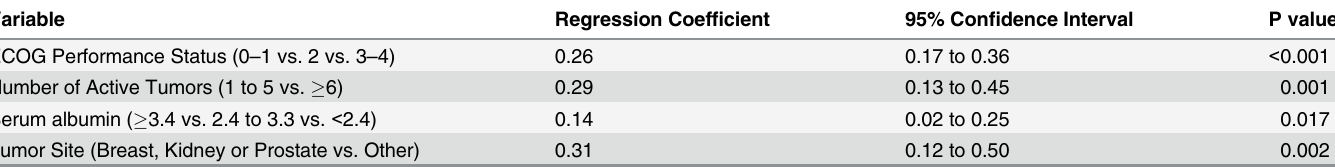
Table 4. Linear regression of predictors of 6-month survival.